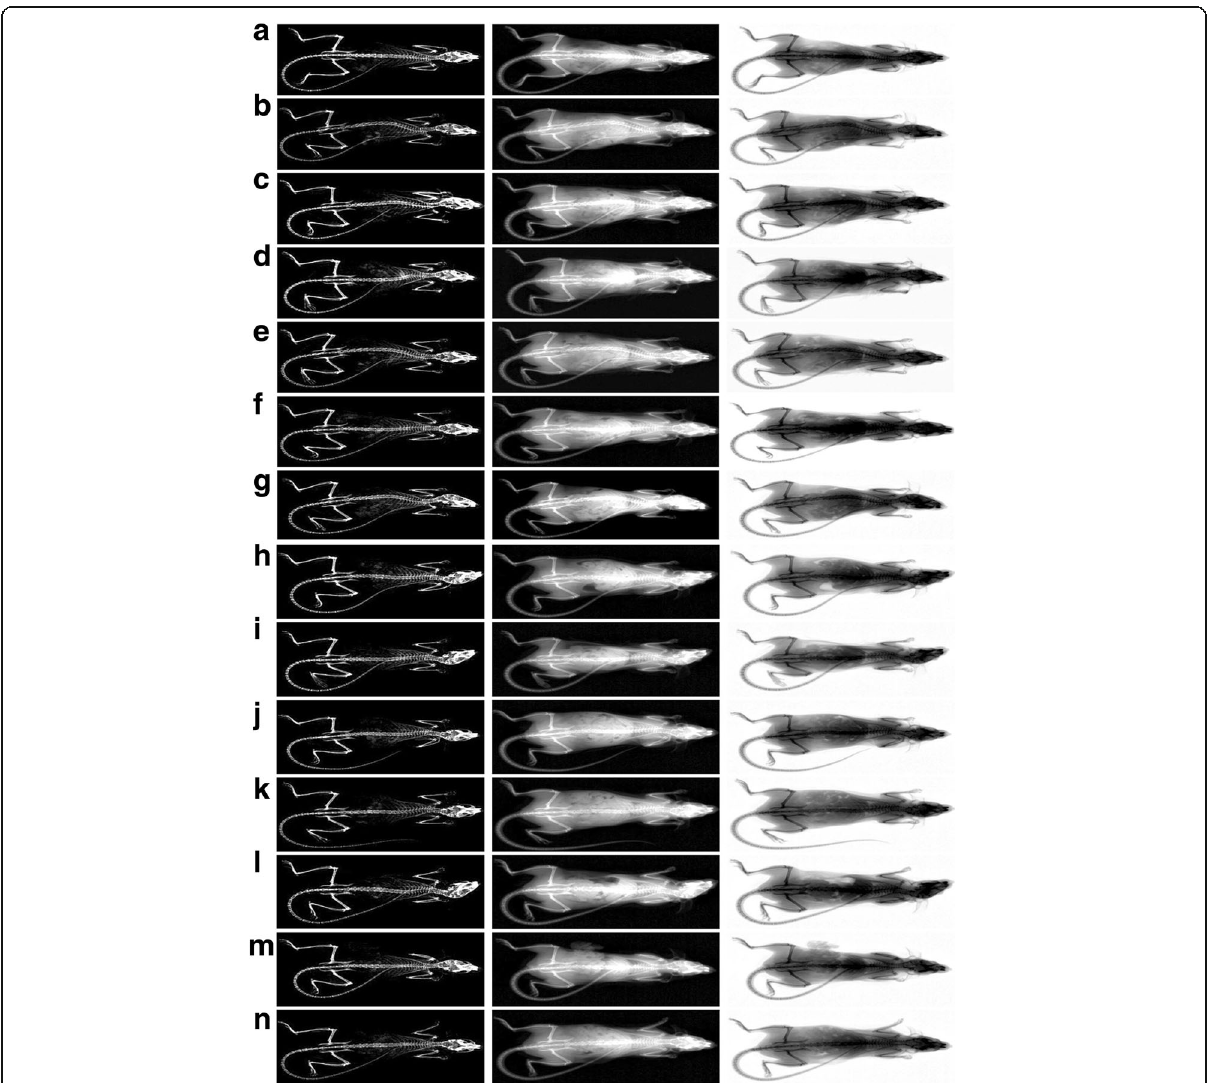
Fig. 4 Representative whole body DEXA images, taken from sham-operated and OVX mice. a = Sham-operated and distilled water administered sham vehicle control mice. b = Distilled water administered OVX control mice. c = RES 2.5 mg/kg orally administered OVX mice. d = EAP single formula 200 mg/kg orally administered OVX mice. e = TM single formula 200 mg/kg orally administered OVX mice. f = EAP:TM 1:1 (g/g) mixed formula 200 mg/kg orally administered OVX mice. g = EAP:TM 1:3 (g/g) mixed formula 200 mg/kg orally administered OVX mice. h = EAP:TM